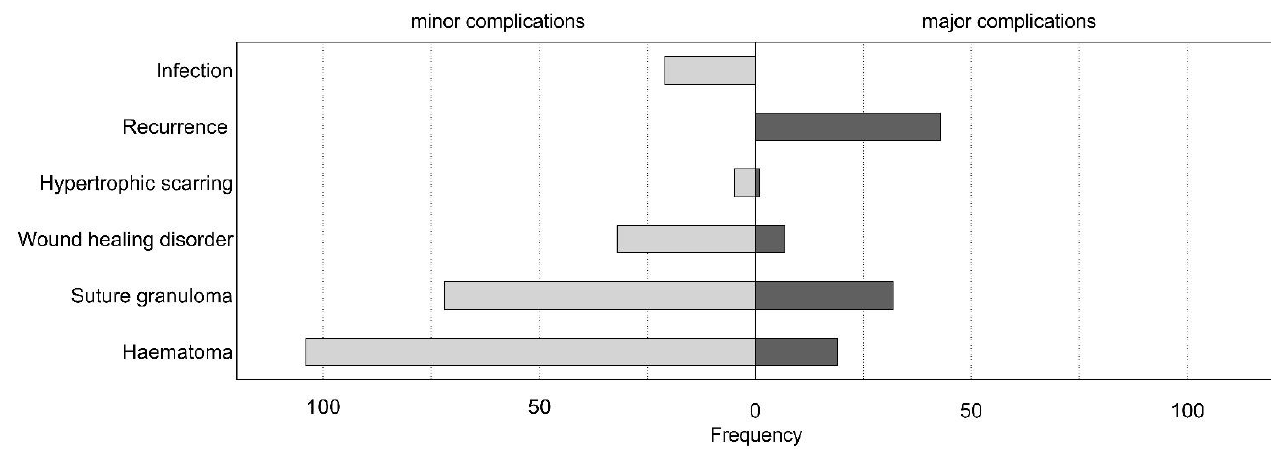
Figure 3. Histogram of individual minor and major complications in direct comparison following the Lemperle otoplasty 138